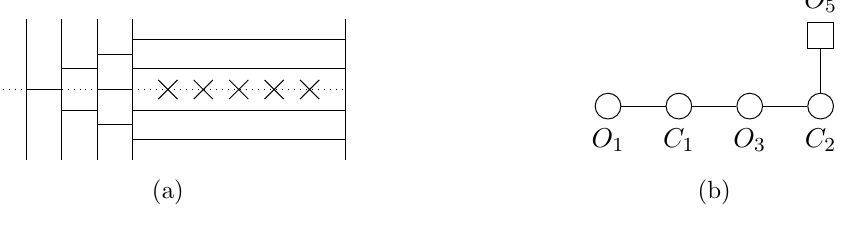
Figure 27. Orthosymplectic model with n s = n d = 5, ~l d = (4 ; 4 ; 4 ; 4 ; 4), ~l s = (0 ; 2 ; 0 ; 2 ; 0) and rightmost orientifold plane O 3 (cid:0) . (a) is the Coulomb branch brane con(cid:12)guration. (b) is the quiver that can be read from the brane system. The Higgs branch of this model is the closure of the maximal nilpotent orbit of so (5), corresponding to partition (cid:21) = (5): M H = (cid:22) O